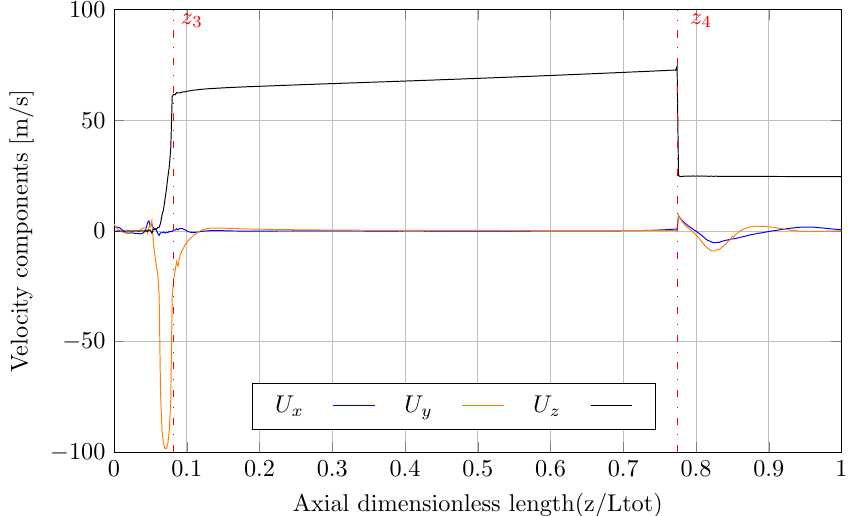
Figure 13. Velocity components averaged over section z (constant), plotted versus z / L tot ( d = 0.77 mm, L = 32.2 mm, D = 3.2 mm, p 2 = 70 kPa). The flow at the end of the annulus region ( z 4 ) detaches, creating a recirculation bubble whose length increases for lower outlet pressure. Moreover, a secondary recirculation region can be recognized close to the lateral wall due to the adverse pressure gradient occurring in the downstream region. In fact, the lowest pressure is localized just after the base of the releasing mass (see Figure 14), and a zone of diffusion is required to recover the outlet pressure. Due to the abrupt increase in the cross-sectional area, occurring while passing from the annular to the terminal region, the velocity decreases and pressure regaining